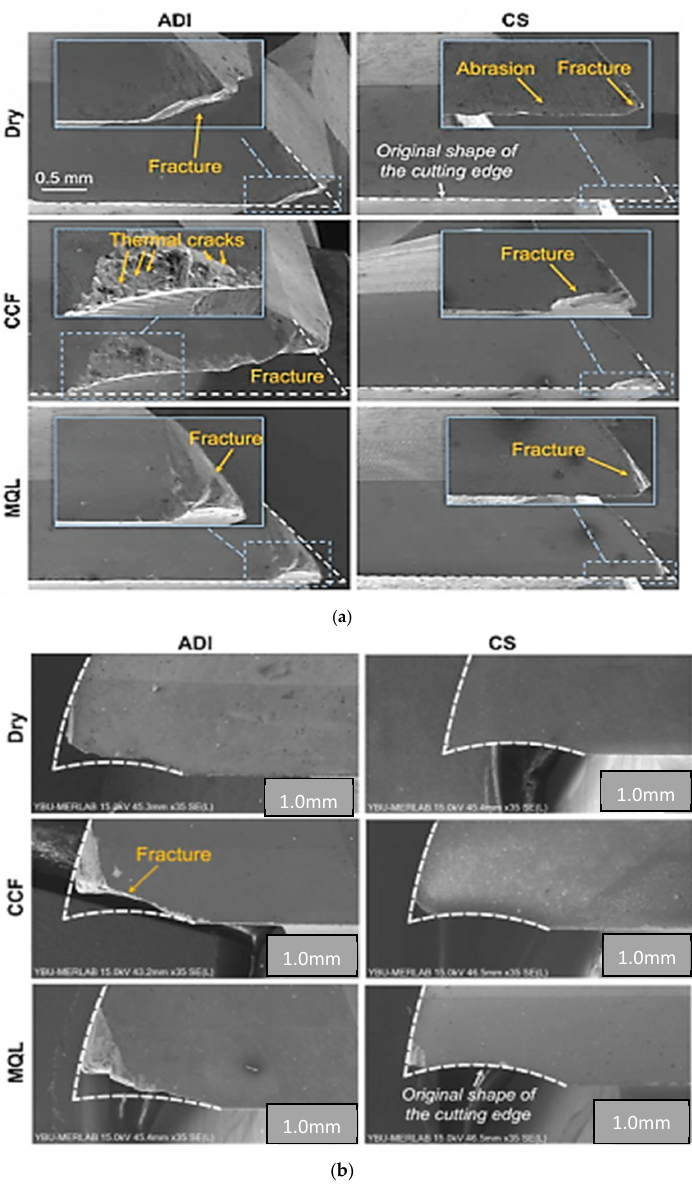
Figure 29. ( a ) Wearing patterns on cutting edges under various milling states [50]. ( b ) Wearing patterns on surfaces under various milling states